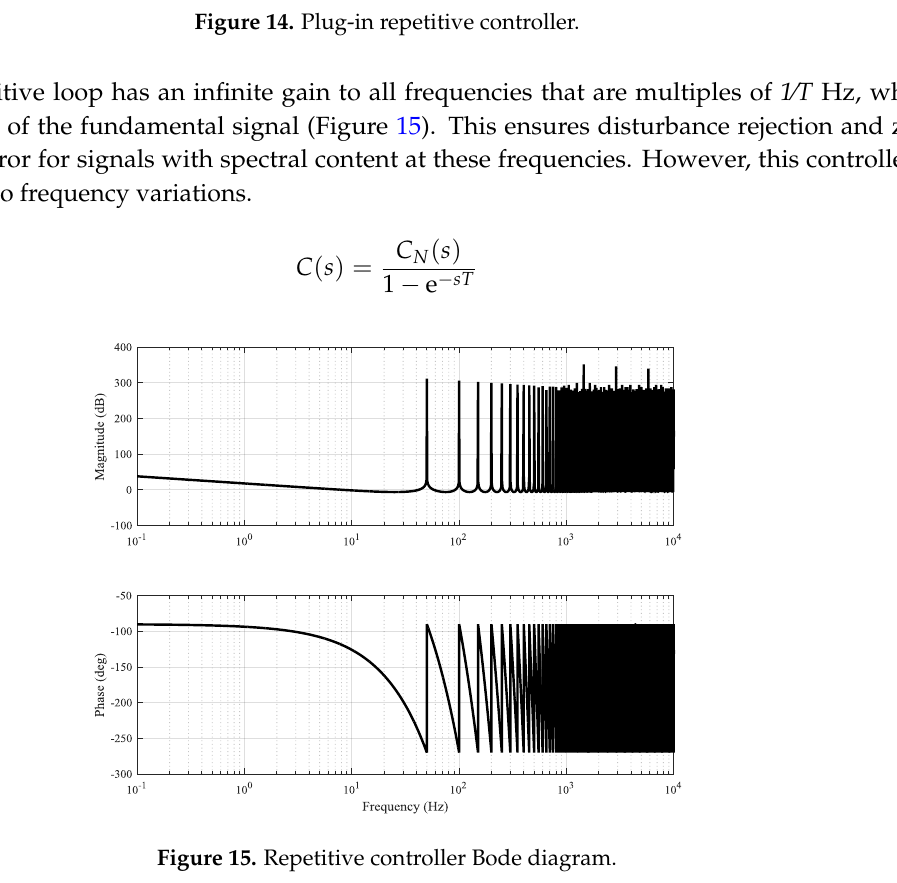
Figure 15. Repetitive controller Bode diagram.